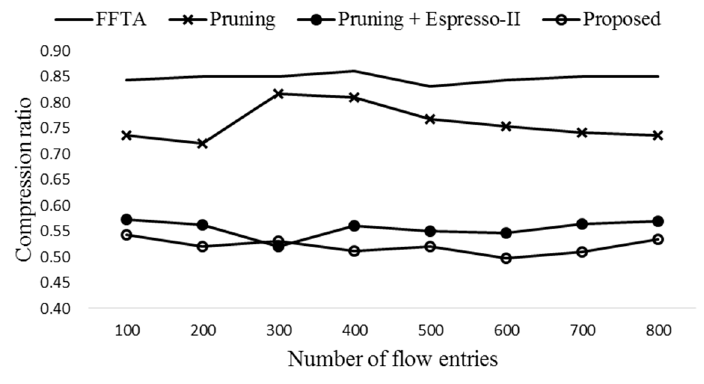
Figure 6. The compression ratios of four different schemes.